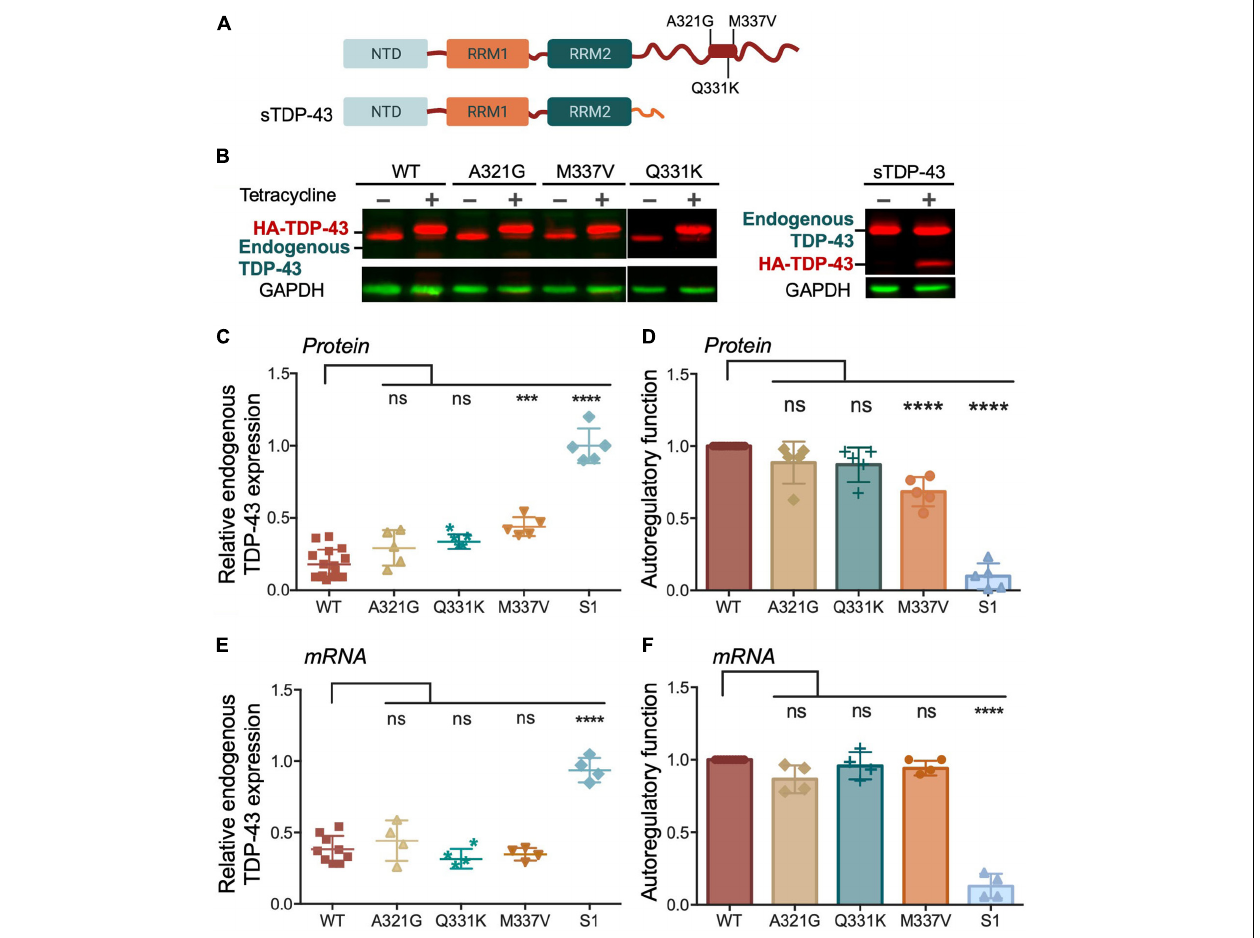
FIGURE 5 | Disease associated TDP-43 variants suppress autoregulation. (A) Single site amino acid substitutions associated with ALS A321G, Q331K, M337V and sTDP-43 are depicted. (B) Representative immunoblots of HEK293 cell lines stably expressing HA-tagged TDP-43 upon tetracycline induction for 72 h. The transgene and endogenous TDP-43 signals appeared as indicated. Immunoblots were probed with TDP-43 antibody (red) and GAPDH as loading control (green). (C) Reduction of endogenous TDP-43 protein levels upon expression of the transgene quantified from panel (B) . Values calculated by the ratio of endogenous TDP-43 levels upon tetracycline induction, relative to non-induced conditions, both normalized to GAPDH. (D) Autoregulatory activity of the ALS mutants and sTDP-43, relative to WT, calculated from the values in panel (C) as endogenous TDP-43 WT /endogenous TDP-43 mutant . (E,F) Autoregulation in terms of Tardbp transcript levels measured by qPCR and quantified as in panels (C,D) . Mean and SD of 5 and 4 biological replicates for protein and RNA, respectively. Analyzed by one-way ANOVA, (B) [ F (9,35) = 43.11, P < 0.0001], and (C) [ F (9,34) = 82.45, P < 0.0001]. Dunnett’s multiple comparisons test was used to compare selected groups. *** P ≤ 0.001, **** P ≤ 0.0001. (D) Protein turnover estimated by measuring TDP-43 protein normalized to GAPDH at different time points post cycloheximide (CHX) treatment, as indicated. Cells expressing WT and M337V, as well as endogenous TDP-43, were treated with CHX (100 µ g/mL) after 72 h of induced transgene expression. Mean and SD of ≥ 3 biological